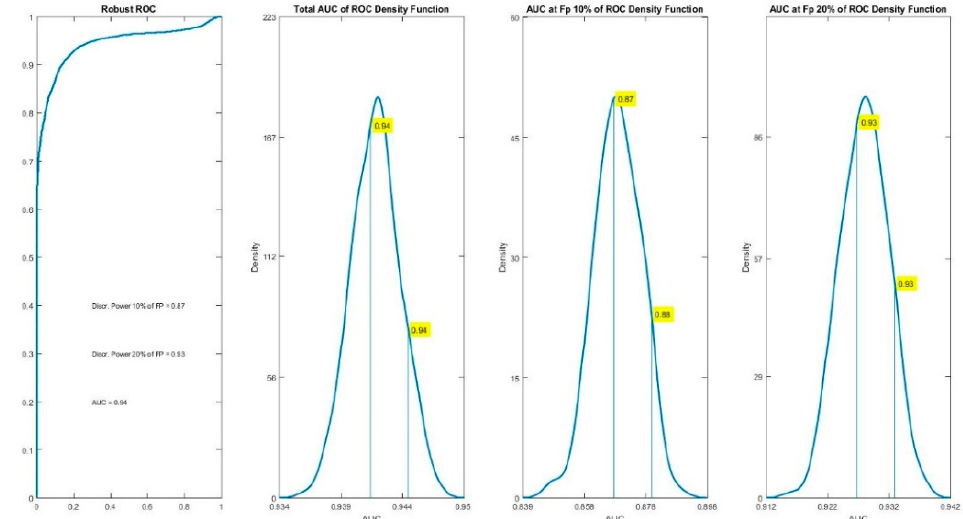
Figure 4. rAUC for the classification equation showing a value of 0.94, which indicates almost perfect sensitivity and specificity. The three panels at the right show the density functions of the total rAUC as well as the discrimination power at the 10% and 20% of False Positives, obtained by the 500 random realizations. The discrimination power at the 50% of the density function was of 0.87 for the 10% of False Positives and 0.93 at the 20% of False Positives.